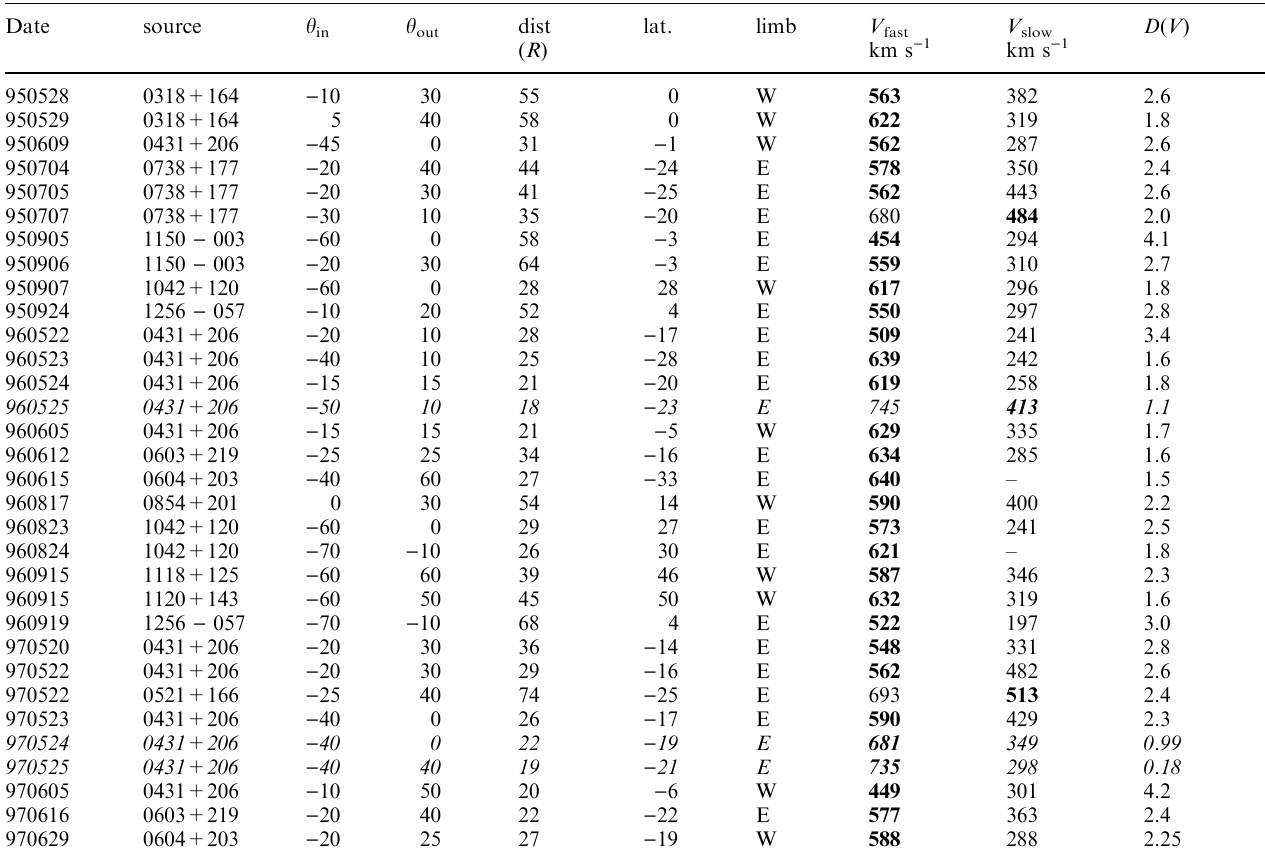
Table 3. Summary of probable compression regions in EISCAT IPS data, 1995–1997 (as determined from white-light data). In each case the velocity of the dominant stream is shown in bold type